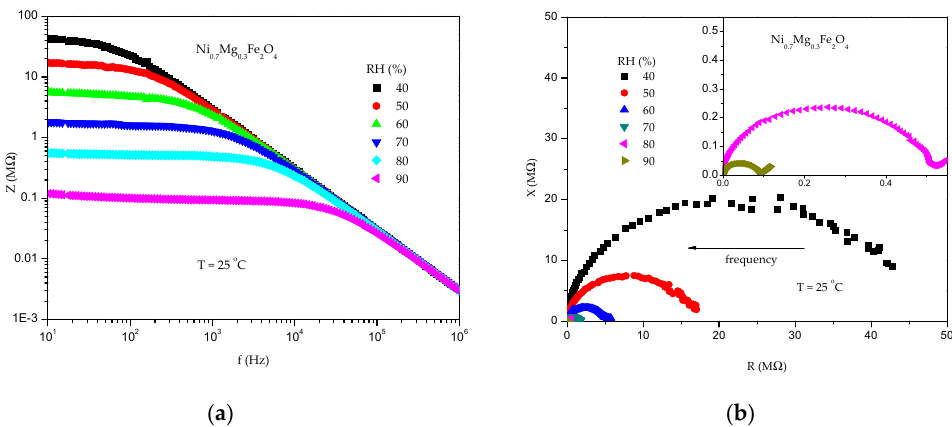
Figure 11. Change of impedance with frequency ( a ) and complex impedance ( b ) in the RH range of 40-90% for Ni 0.7 Mg 0.3 Fe 2 O 4.